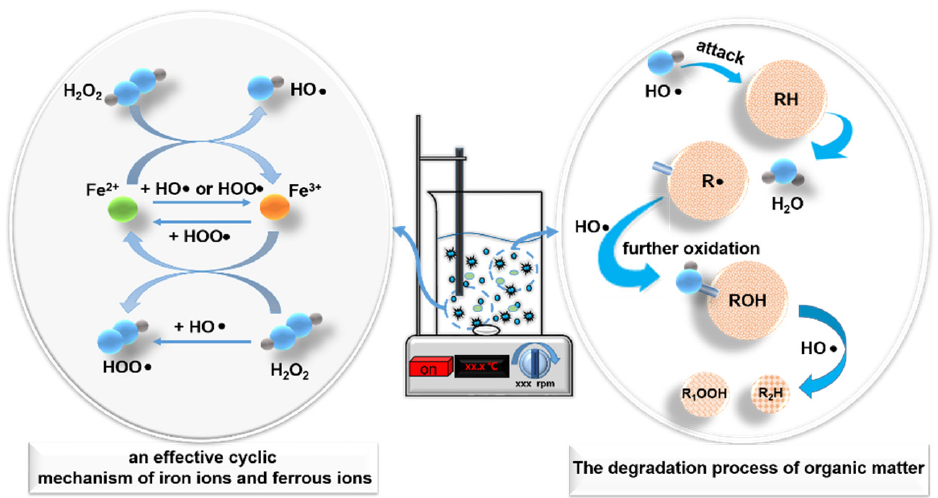
Figure 9. Schematic diagram of Fenton reaction process.